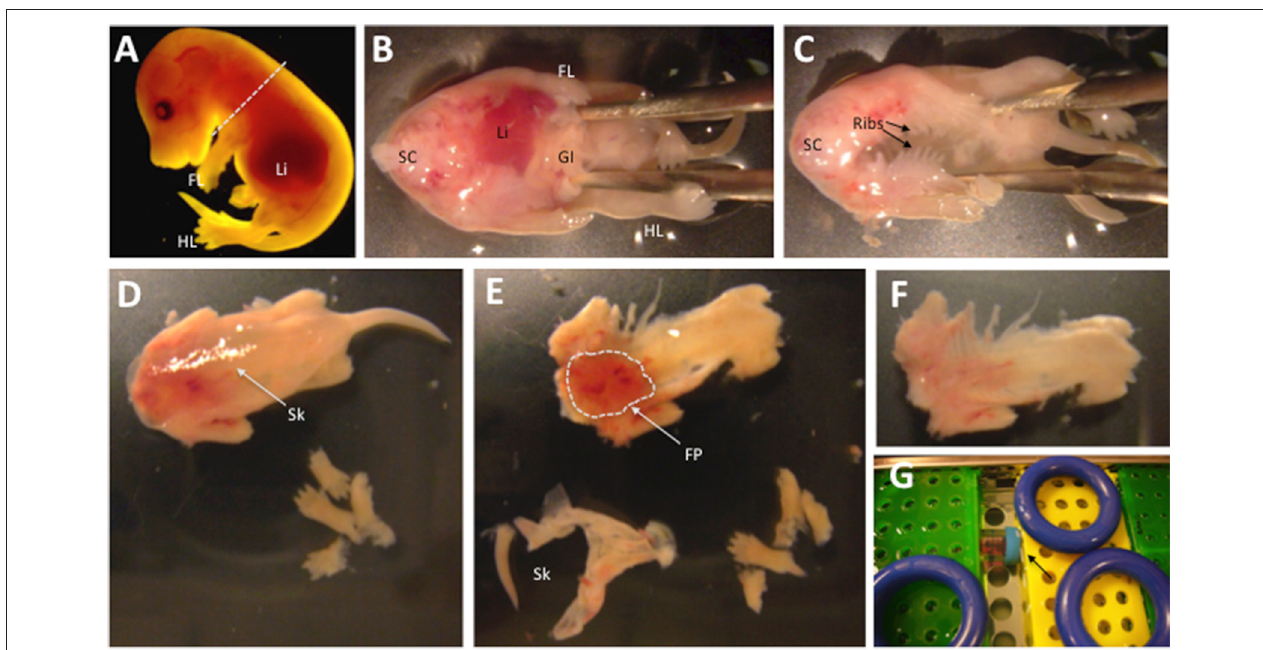
FIGURE 6 | Progressive dissection of an E15.5 fetus. (A) The head of the fetus is removed. (B) After placing the fetus with the ventral portion facing up, forceps are used to cut the thorax and abdomen and expose the internal organs. (C) The fetus shows an empty body cavity after removal of the heart, lungs, liver, gastrointestinal tract and other internal organs. (D) E15.5 fetus with the dorsal portion facing up, from which limb extremities have been dissected out. The skin (Sk) is translucent and clearly visible. (E) A skinned fetus presenting large inter-scapular fat pads (FP, dashed line). (F) A skinned fetus from which inter-scapular fat pads have been removed. (G) Position of the tubes (arrow) in the water bath during enzymatic digestion. Additional abbreviations in the scheme: Li, Liver; FL, fore limes; HL, hind limbs; SC, spinal cord; GI, gastrointestinal tract.